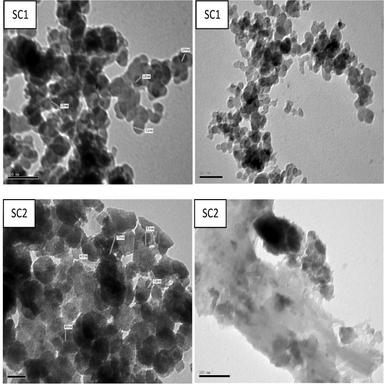
SEM images (different magnifications) of milled SiO2@C powders prepared from rice husk.